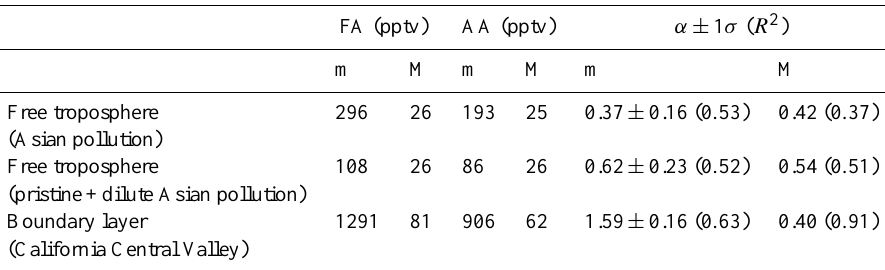
Table 4. The increase in the median measured (m) FA and AA in polluted air observed during INTEX-B/IMPEX reflects the importance of secondary sources in the budget of FA and AA. These sources are missing from the model (M). α is the slope of the linear fit: AA= α FA + β calculated using York’s method (York et al., 2004) for the measurement (ordinary least square for the model). Characterization of the air masses follows the approach of Dunlea et al.